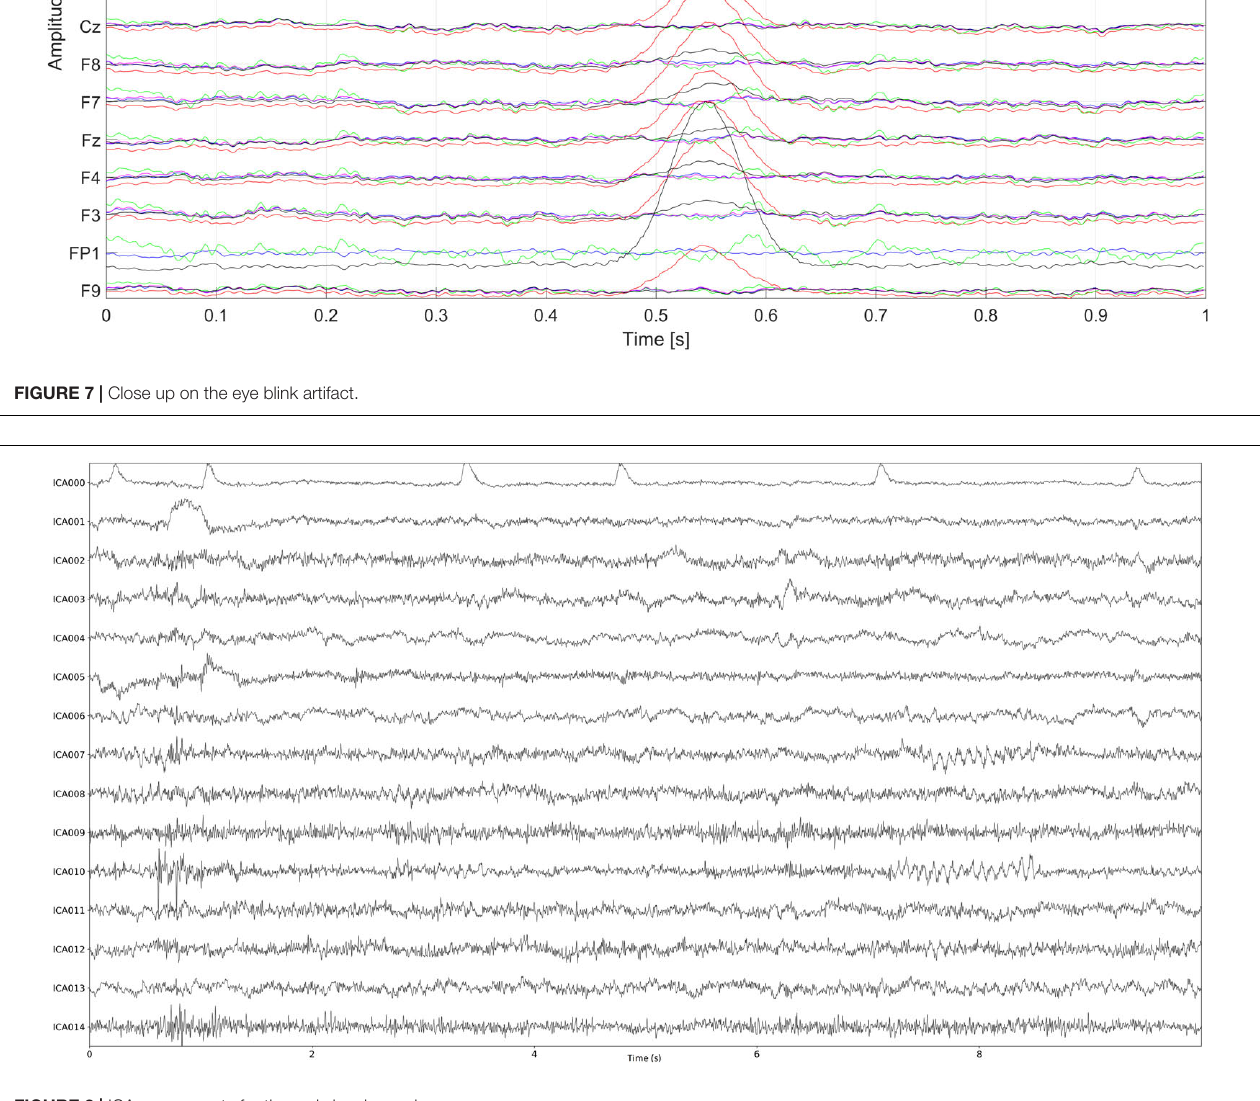
FIGURE 8 | ICA components for the real signal